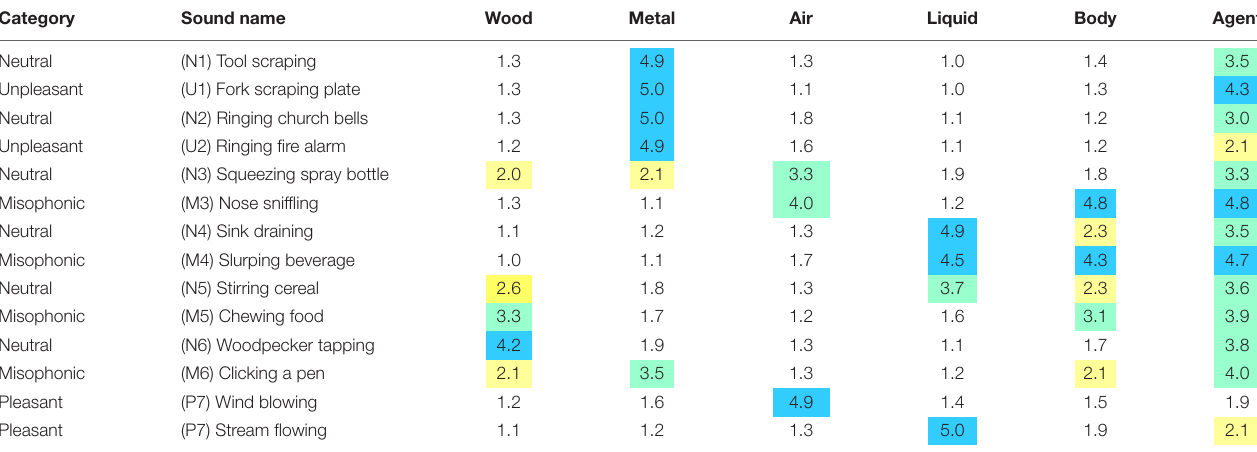
TABLE 3B | Mean causal material and causal agent property ratings taken across all participants are indicated in each table entry, with rows corresponding to one of the fourteen sound tokens and columns corresponding to the five materials and one agent.